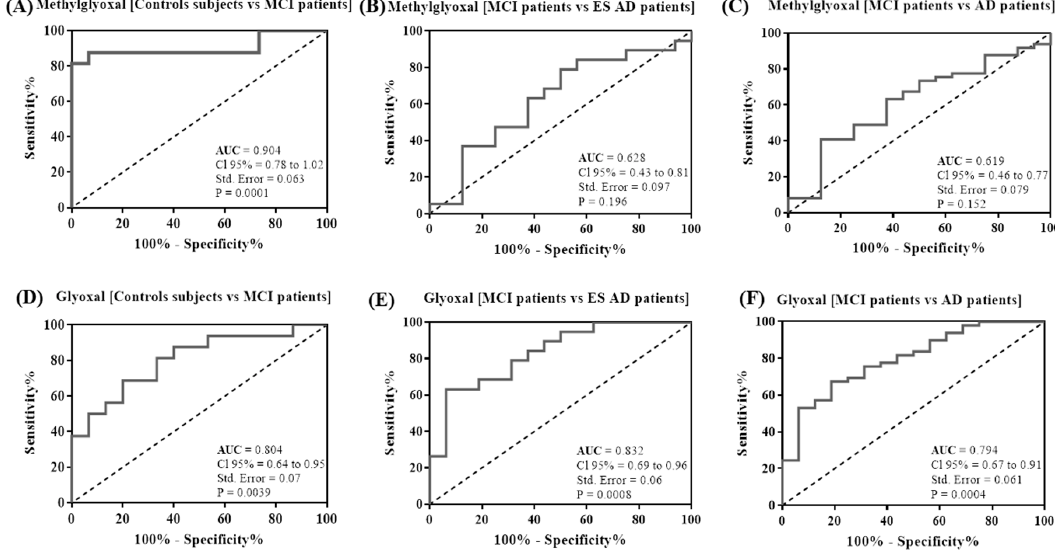
Figure 2. Receiver operating characteristic (ROC) curve analysis. The plots represent the performance of MG and GO serum levels to differentiate MCI patients to control subjects ( A , D ) and to early AD patients ( B , E ) and all AD patients ( C , F) . Area under the curve (AUC) values, 95% confidence intervals (CI 95%), standard error (Std. Error) and p values are indicated on the curve. Table 2. Cutoff values to separate MCI patients to control subjects and early and all AD patients. Groups Cutt off (nM)